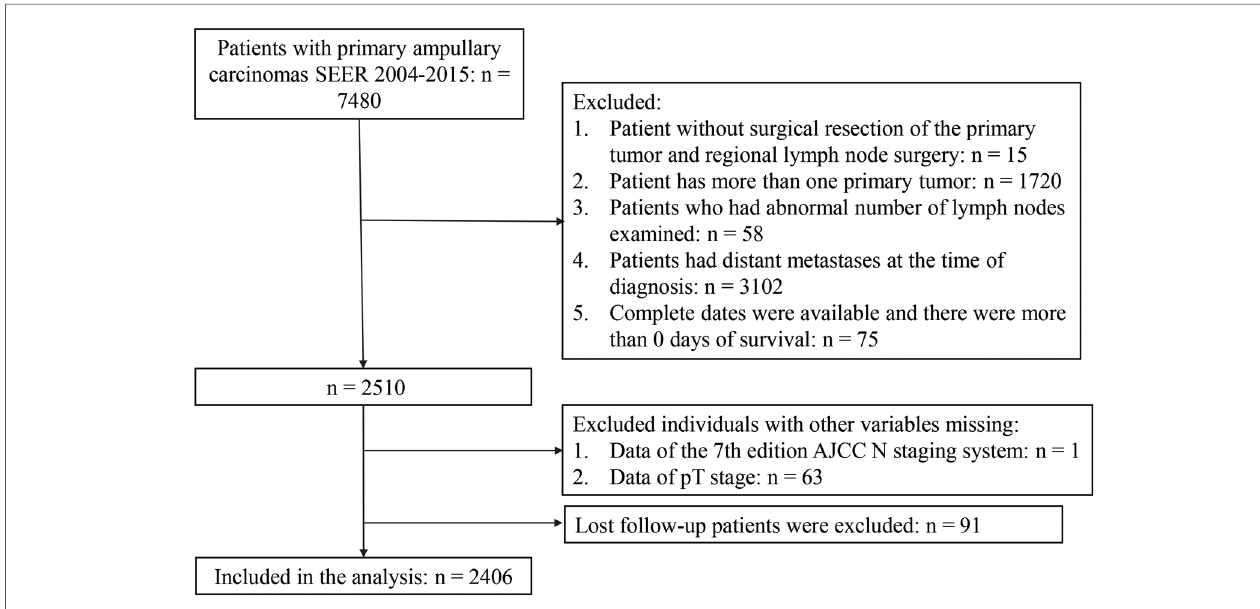
FIGURE 1 Flow chart of the study